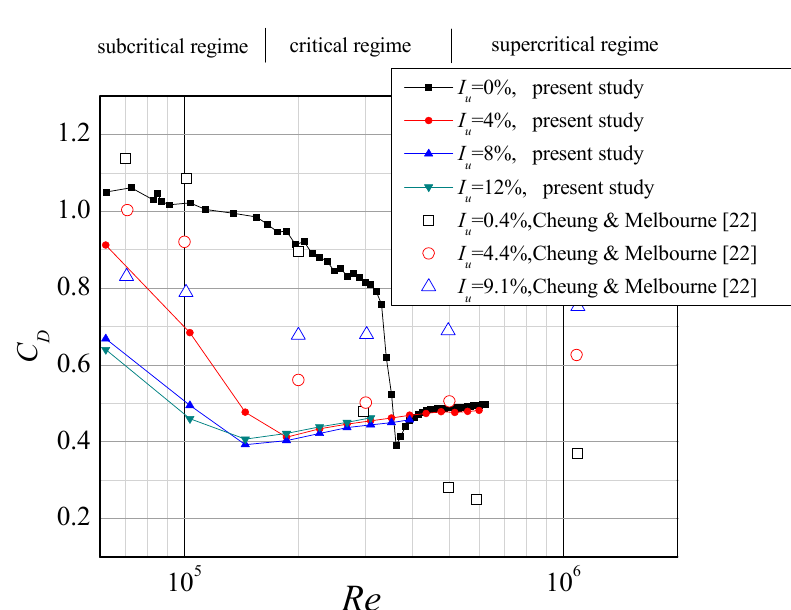
Figure 16 . Drag coefficient of circular cylinder in turbulent flow. Figure 16. Drag coe ffi cient of circular cylinder in turbulent